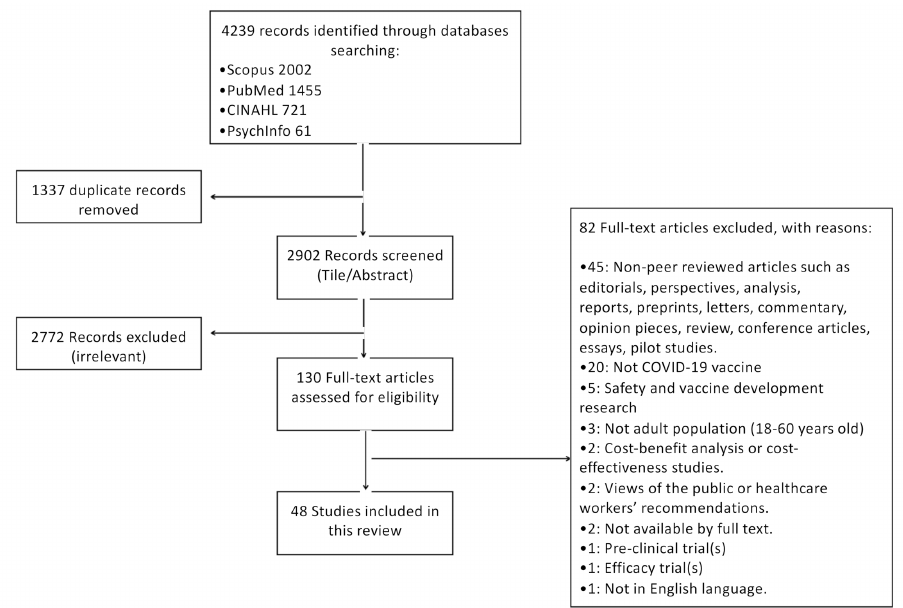
Figure 1. Preferred Reporting Items for Systematic Reviews and Meta Analyses (PRISMA) flow chart of article extraction from the literature